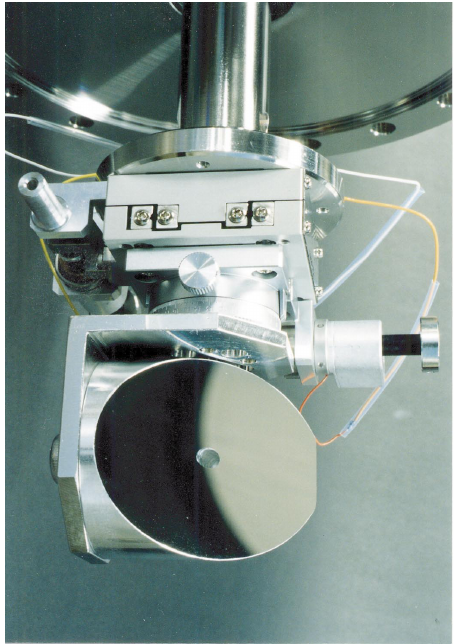
FIG. 12. (Color) Picture of the parabolic mirror with a through hole at the